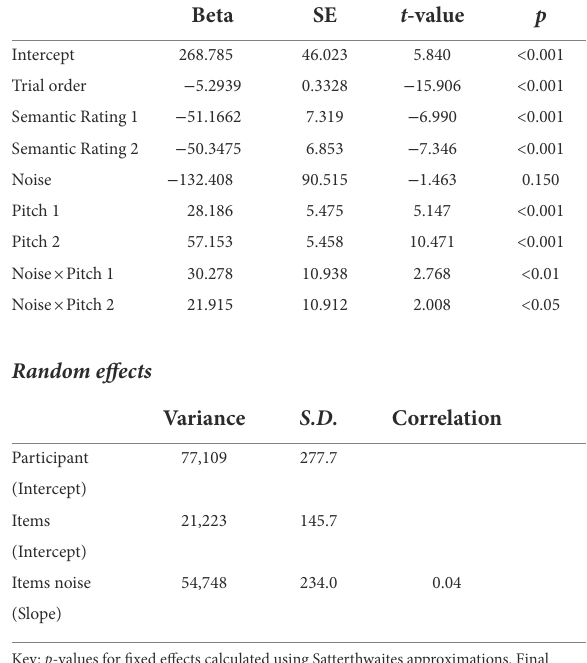
Key: p -values for fixed effects calculated using Satterthwaites approximations. Model equation: PupilSize ~ (1 + Task|Subject) + (1|Item) + TrialOrder + Semantic Rating + (Task × Pitch).